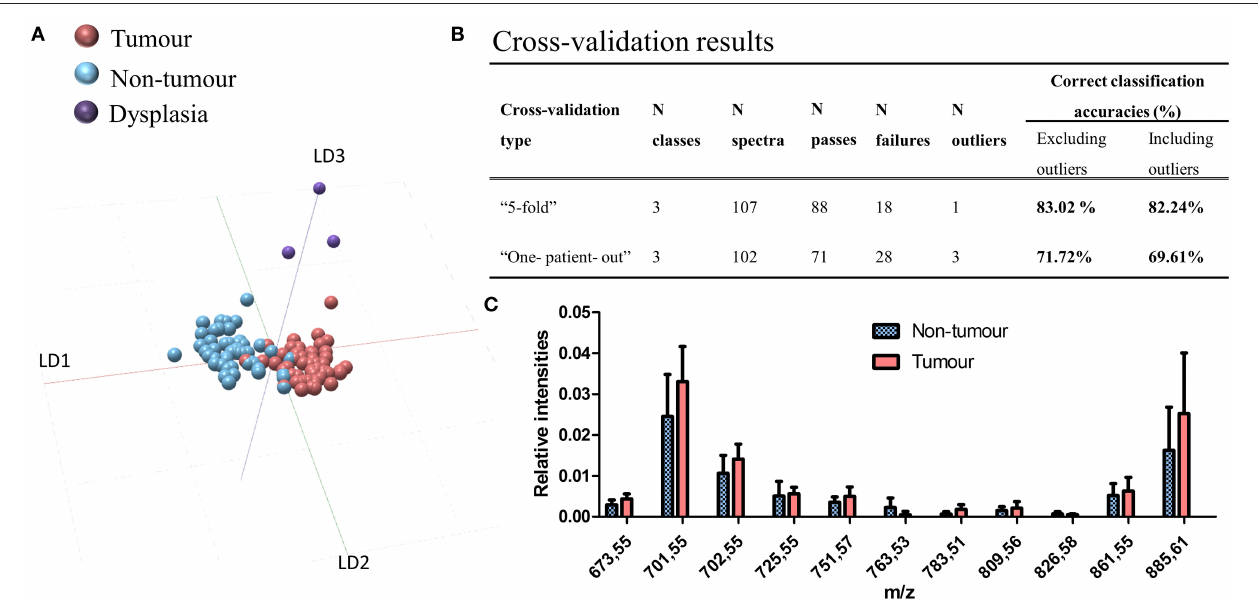
FIGURE 1 | Formalin-fixed paraffin-embedded (FFPE) tissue analysis by the SpiderMass. (A) Principal component analysis-linear discriminant analysis (PCA-LDA) classification model based on the tumor, nontumor, and dysplasia annotated regions of the tissue. (B) Cross-validation results. Cross-validation results of the 3-class model with model type, cross-validation type, N of classes, N spectra, N of passes as well as N of failures, N outliers, and % of correct classification accuracies after cross-validation. (C) Relative intensity boxplots of the selected peaks showing a discrimination in LD1 for the nontumor and tumor regions, respectively. The intensities were normalized to the total ion chromatogram and represented as boxplots with the Tukey method whisker